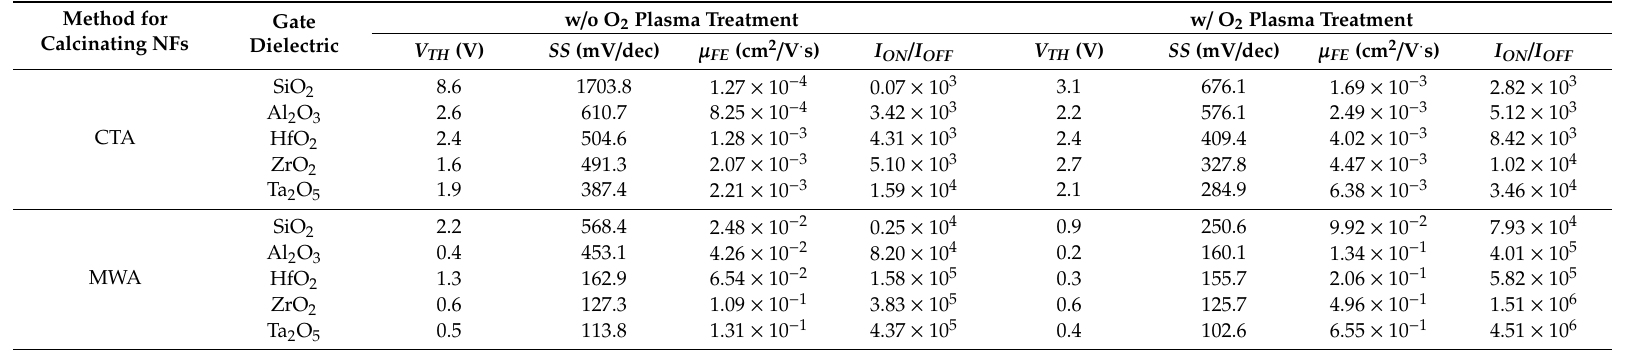
Table 1. Electrical parameters of IGZO NF FETs based on di ff erent high- k gate